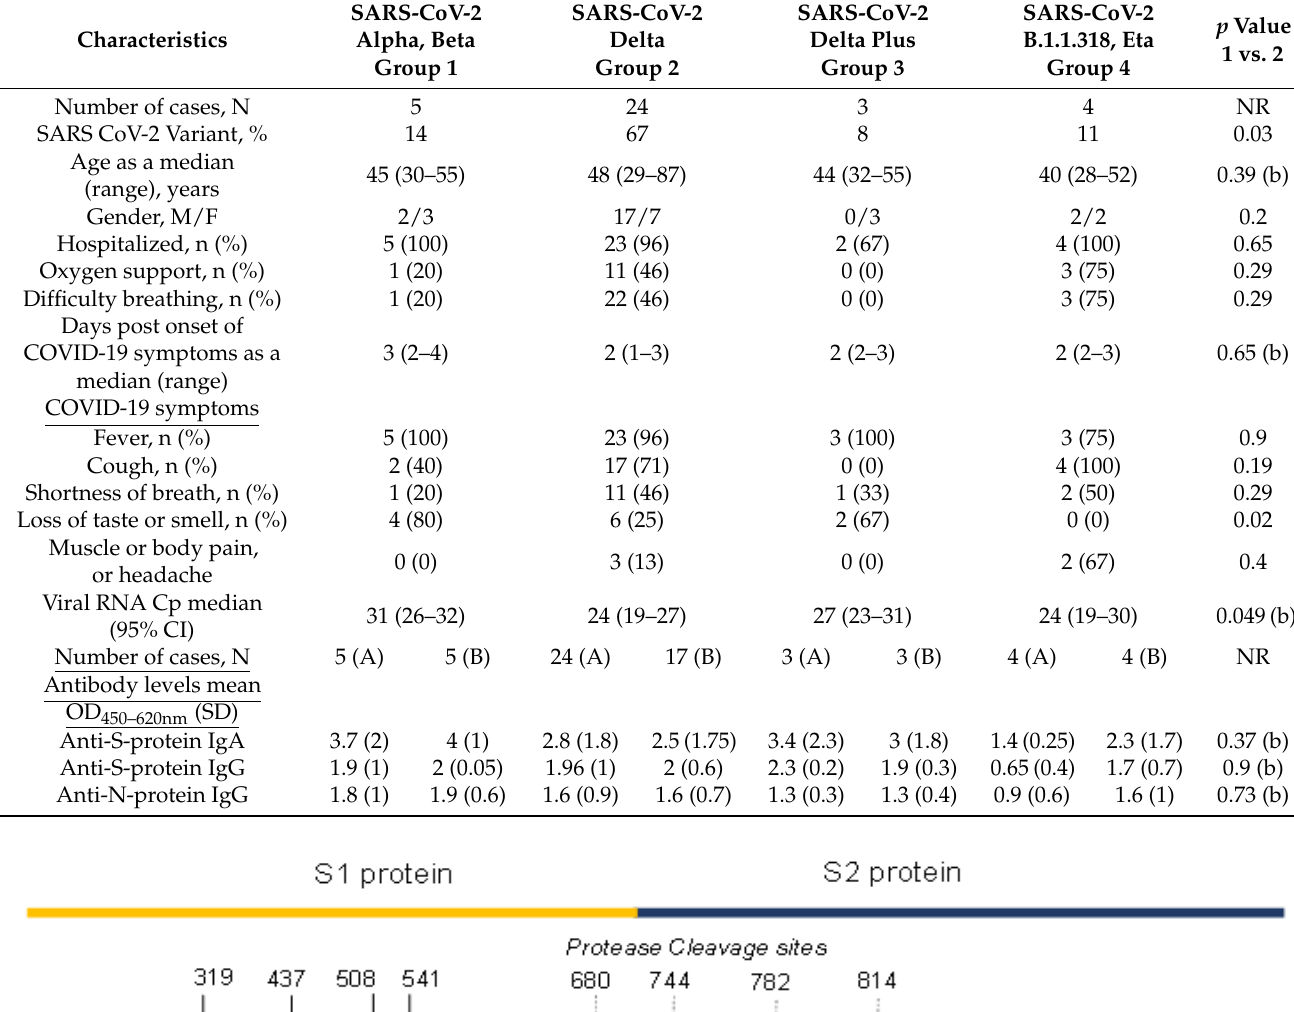
Table 1. Patient characteristics. The patient characteristics in four groups of SARS-CoV-2 variants were compared. The p - values are either the rank sum of median differences between group 1 versus group 2 in the Mann–Whitney independent test or the difference in proportions between group 1 versus group 2 in the Chi-square analysis (b). Time points (A) = day